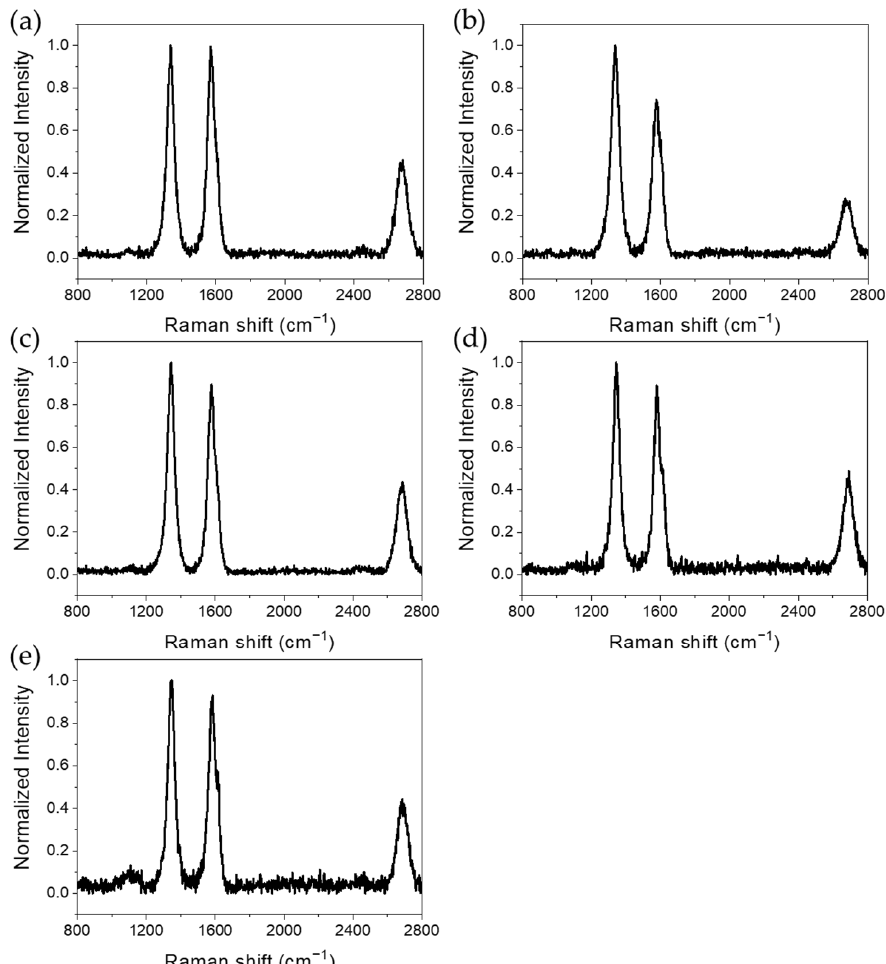
Figure 8. Raman spectra of (a) purified MWCNTs and multi ‐ vacancy ‐ defect MWCNTs after the removal of ( b ) Co 3 O 4 , ( c ) Fe 2 O 3 , ( d ) Mn 3 O 4 , and ( e ) NiO NPs.